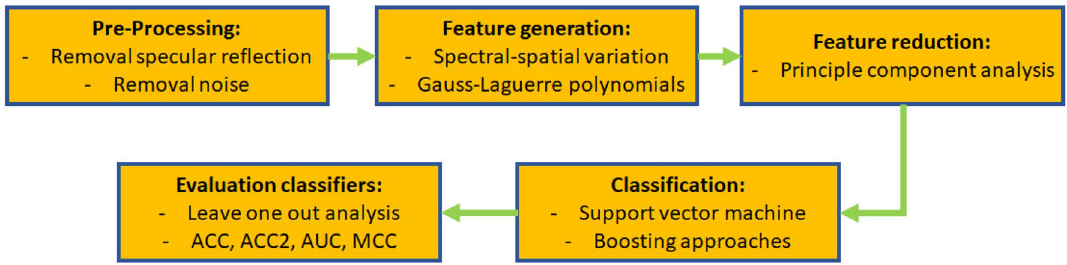
Figure 2. Flowchart of the data analysis. It groups in the five steps: pre-processing, feature generation, feature reduction, classification and evaluation of the macroscopic appearance by the experienced endoscopists, were additionally evaluated with MSI. A biopsy for neoplasm assessment could not be done, as the mice were required for other purposes later on. In total, 25 mice were investigated by this procedure. Each mouse had at least one neoplastic lesion. Lesions for spectral analysis were identified by two medical experts by classification as a “definitively neoplastic lesion” based on macroscopic appearance. To increase accuracy, assessment was performed by two medical experts. Only one of them drew the lesion margin. 542 nm, then For the MSI in this study, nine images were taken in the following order: one image for (cid:31) = the complete MSI series consisting of the seven wavelength bands as described in Table 1 and finally again one 542 nm. Before any further analysis, the first and the last image were compared. If both of them image for (cid:31) = change significantly, the image was not used for further analysis due to movement-artefacts from the mouse. The margin of the lesion was drawn on the first and on the last image. Both margins were drawn in comparison with a video from a second endoscopic procedure of each mouse. Potential safety risks for human studies The current imaging procedure imposes no major risks to potential patients compared to white light endoscopy as the required light intensities are similar. There are two potential minor risks: First, light with a wavelength of 397 nm is used. Long term exposure of blue light is known to increase the risk of skin carcinomas. However, the exposure time in this study is orders of magnitude lower than it is required for increased risks of carcinomas. Second, the usage of the MSI might increase the time of the endoscopic procedure in comparison to the white light endoscopic procedure. Data analysis. The analysis is done with a pixel-per-pixel classification process. All data analysis is done with a leave-one-out strategy (LOOS) in which 24 mice are used for training and one for testing. No mouse was excluded from the analysis. In general, the data analysis is a modified version of that presented in two previous studies 16, 17 with very detailed descriptions in the latter one 17 . In general, the data analysis consists out of the fol- lowing steps shown in Fig. 2: The classification process is described in detail later in this section. In the pre-processing step, noise is mini-